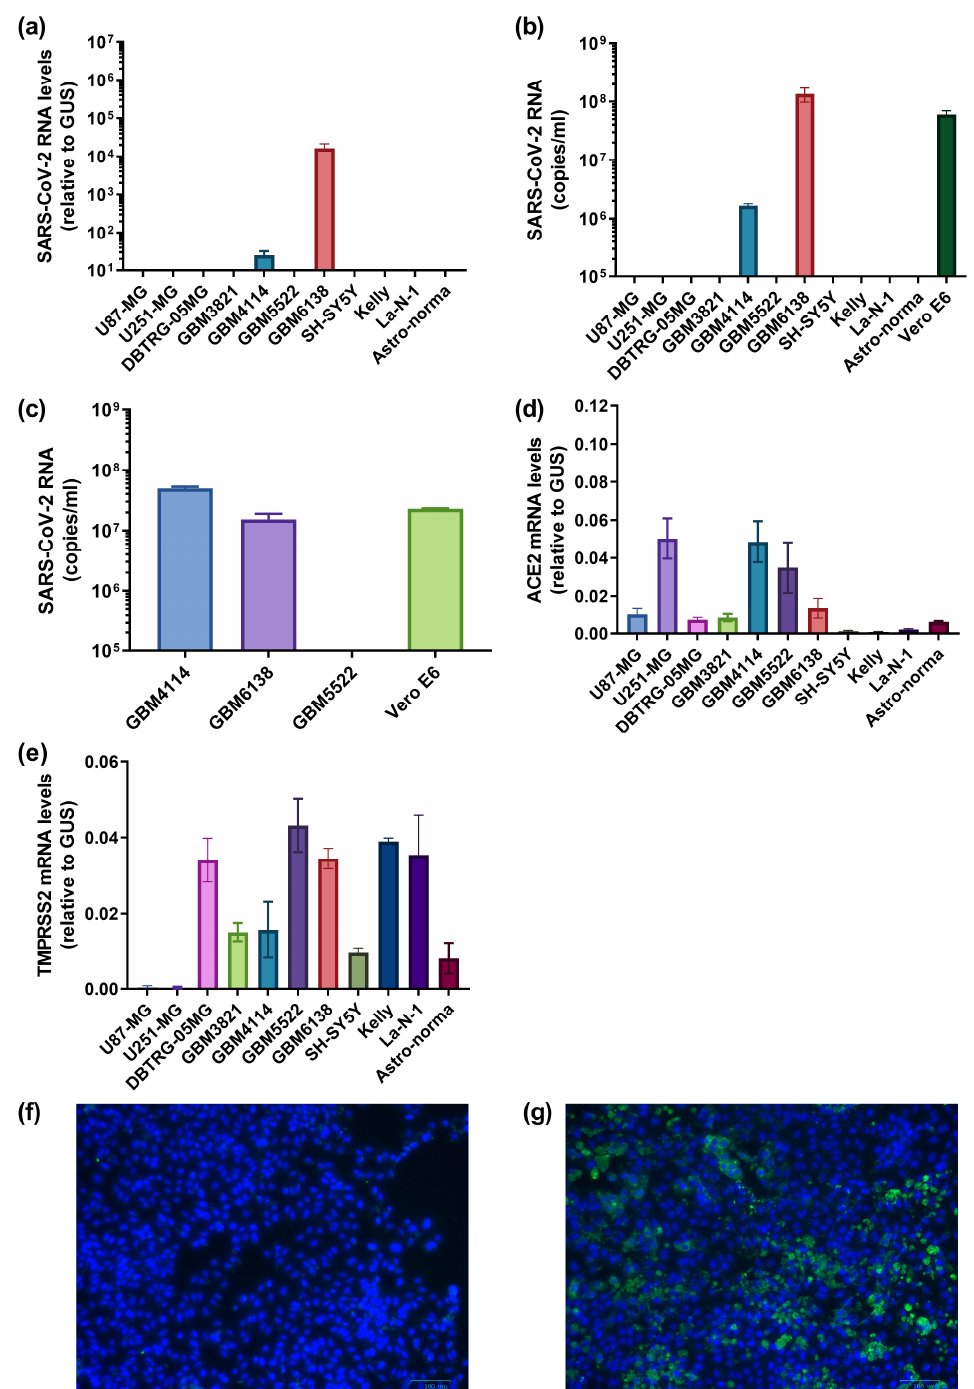
Figure 4. SARS-CoV-2 may establish a productive infection in human high-grade glioblastoma. Glioblastoma U87-MG, U251-MG, DBTRG-05MG, high-grade low-passage glioblastoma (GBM3821, GBM4114, GBM5522 and GBM6138), neuroblastoma (SH-SY5Y, Kelly or La-N-1) or primary embry- onic astrocytes were infected with SARS-CoV-2, 2 h later the medium was replaced, and levels of the viral RNA were assessed by RT-qPCR in cells ( a ) or conditioned medium ( b ). ( c ) The conditioned medium from GBM4114, GBM5522 and GBM6138 after infection was used to treat Vero E6 cells, and SARS-CoV-2 RNA in media was monitored by RT-qPCR. ( d , e ) Levels of ACE2 and TMPRSS2 mRNAs were measured in glioblastoma and neuroblastoma cell lines. The values are the means ± standard deviation (S.D.). ( f , g ) Immunostaining of the GBM6138 cell line infected with SARS-CoV-2 using non-immune serum ( f ) and immune ( g )